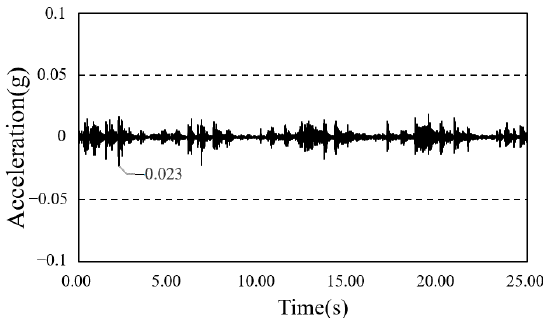
Figure 15. Time history of acceleration after cladding completion (South-North church).